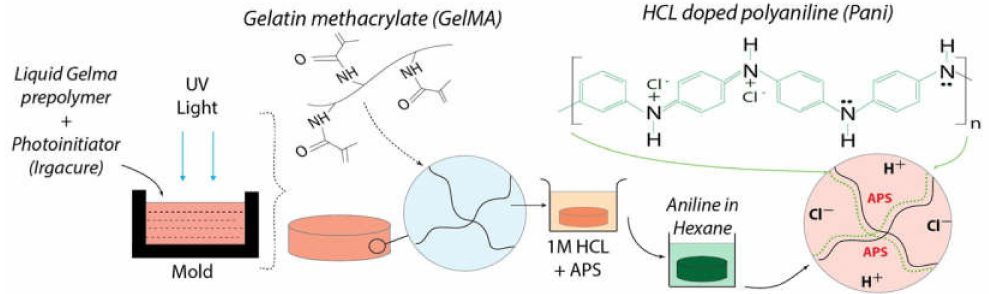
Figure 3. Fabrication of Pani-GelMA conductive hydrogels by a post polymerization strategy through immersion in preformed hydrogel in an oxidant solution followed by subsequent immersion in an aniline / hexane solution for obtaining the conductive hydrogel [40]. Reprinted from [40] with permission from